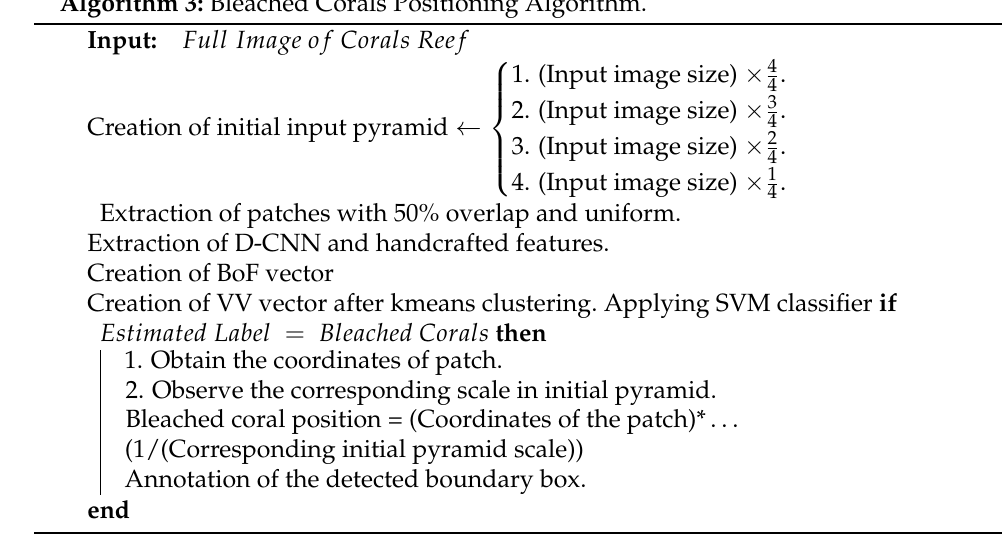
Algorithm 3: Bleached Corals Positioning Algorithm.